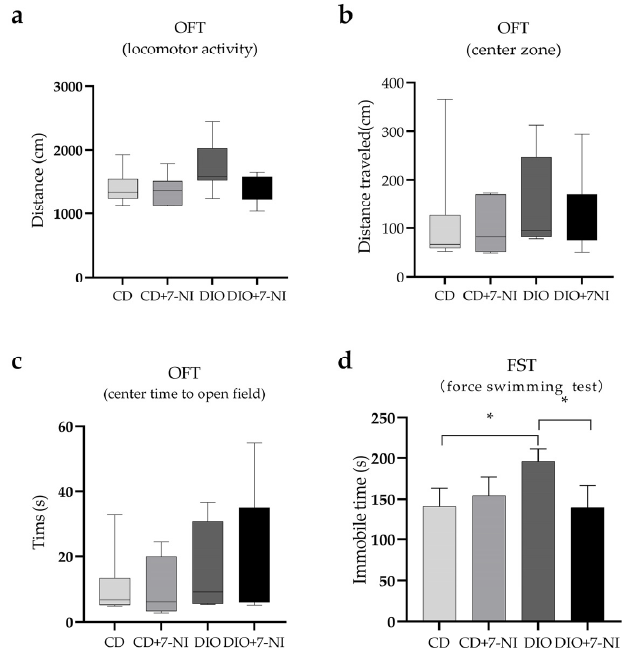
Figure 8. 7-NI improves depressive behavior in DIO mice. Exercise ability ( a ), central travel distance ( b ) and time spent ( c ) by DIO mice in during OFT. The immobility time of mice in each group during forced swimming ( d ). * p < 0.05, When compared with the corresponding group, results are presented as the mean ± SD or median (quartile spacing).